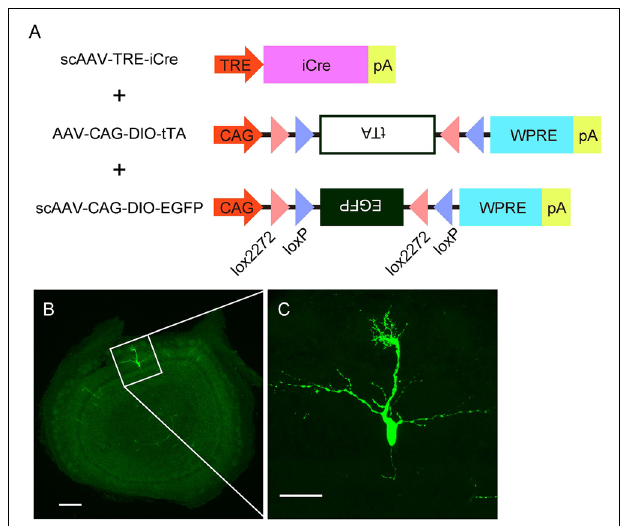
FIGURE 4 | AAV-mediated single-cell labeling of mitral cells. (A) A schema illustrates the viral contracts used in this study. (B) A representative image of a coronal OB section from an AAV-injected mouse at P3. Scale bar, 200 µ m. The magnified image of the boxed area is shown in (C) . Scale bar, 50 µ